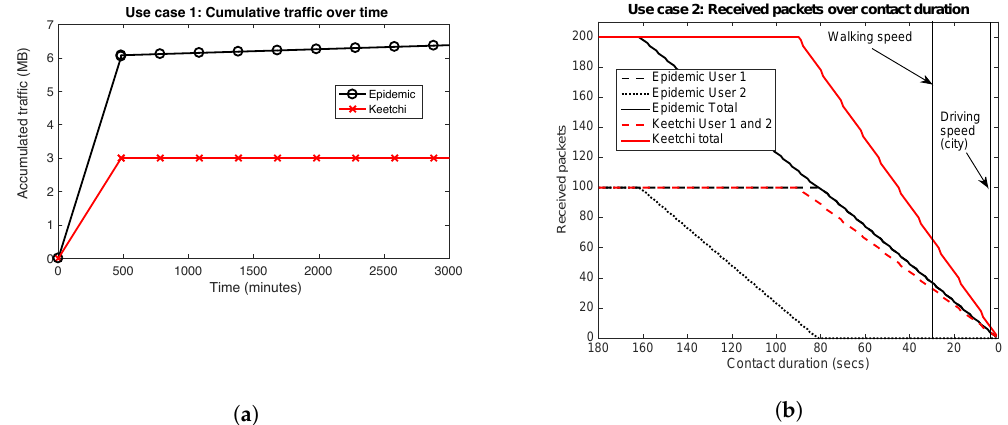
Figure 6. Behaviour of K EETCHI vs. E PIDEMIC in use Case 1 and use Case 2. ( a ) Use Case 1: The induced traffic of E PIDEMIC depends on the total contact length, while K EETCHI exchanges data only once in this scenario. ( b ) Use Case 2: While both protocols experience severe problems (due to short contacts), the total number of received packets of K EETCHI is much higher than for E PIDEMIC . Furthermore, K EETCHI exchanges packets in both directions, while E PIDEMIC works better in one than the other